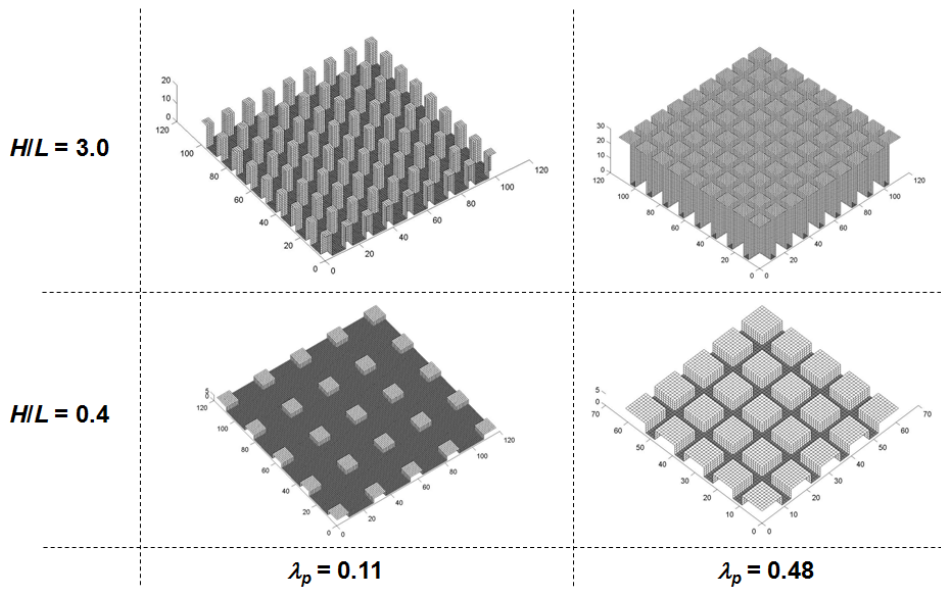
Figure 4. Example TUF3D domains for two λ p and H/L ratios, showing (approximately) the range of geometries considered.